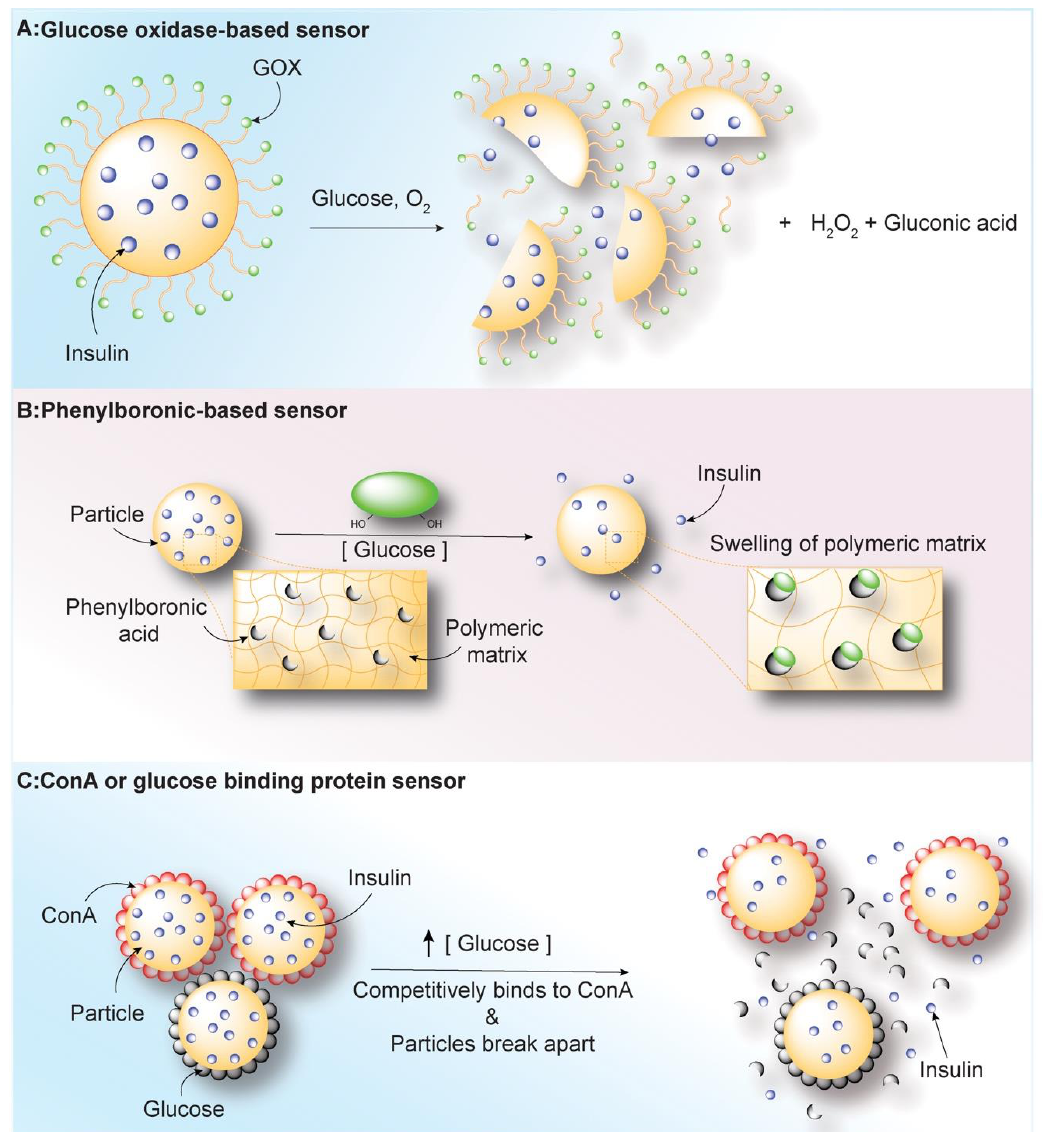
Figure 4. Particle-based glucose sensors. ( A ) Glucose oxidase (GOx)-based systems show high affinity for glucose, GOx catalyzes the oxidation of glucose to gluconolactone firstly with the production of toxic intermediate hydrogen peroxide (H 2 O 2 ), and then gluconolactone is rapidly hydrolyzed to gluconic acid in an aqueous environment. The local acidification in response to elevated glucose levels trigger the release of insulin from particles. ( B ) Phenylboronic acids are Lewis acids that can bind reversibly to cis-1,2 or cis-1,3 diols. This binding drives the swelling of polymeric matrix of particles containing insulin, improving insulin release. ( C ) Concanavilin-A (ConA) is a natural protein containing four binding sites for sugar. Particles containing ConA can release insulin via a competitive binding between glucose and Conc-A upon glucose exposure.